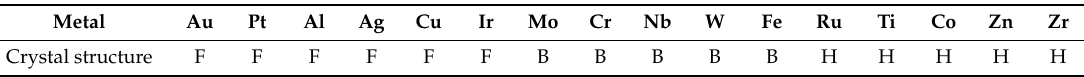
Table 1. Crystal structure types of di ff erent metals (F: face-center cube; B: body-center cube; and H: